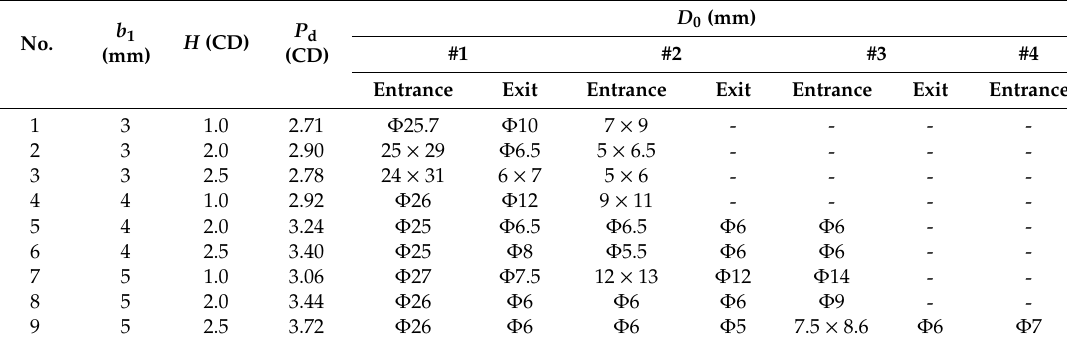
Table 1. Experimental results of RM-CJ penetrating steel targets.